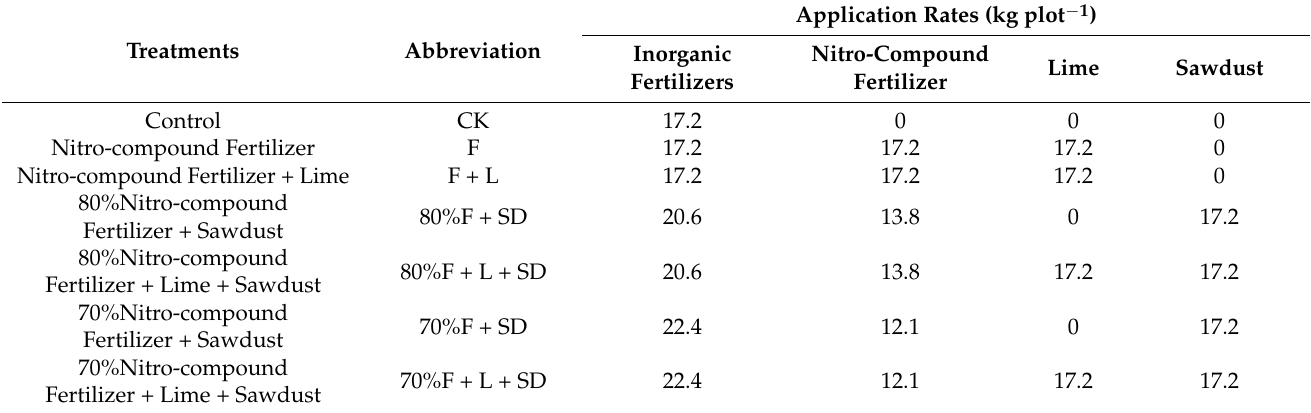
Table 3. Experimental design and application amount of